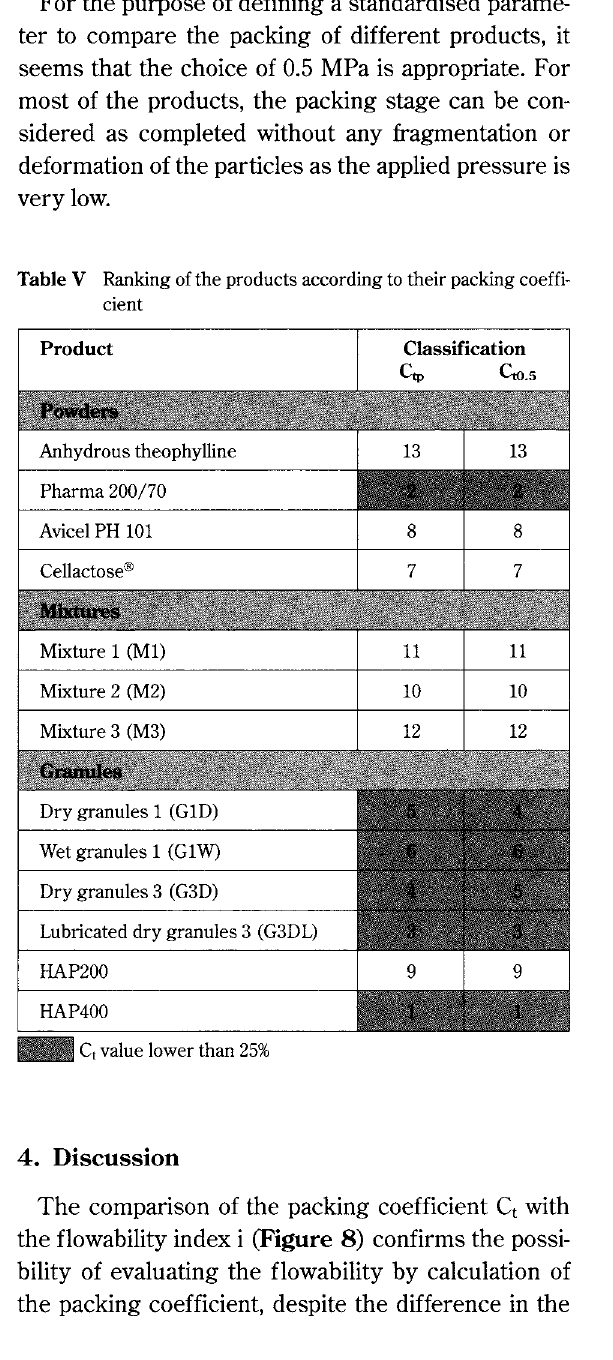
stress region applied. Globally, materials with a